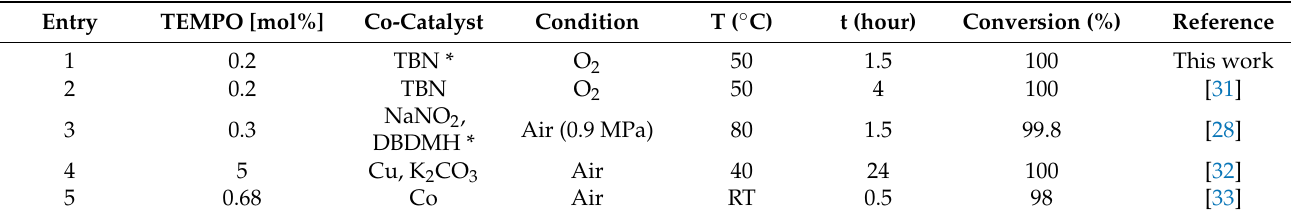
Table 1. Different reaction conditions for the oxidation of benzyl alcohol into benzaldehyde in water with 2,2,6,6-tetramethyl- 1-piperidinyloxy (TEMPO)-based